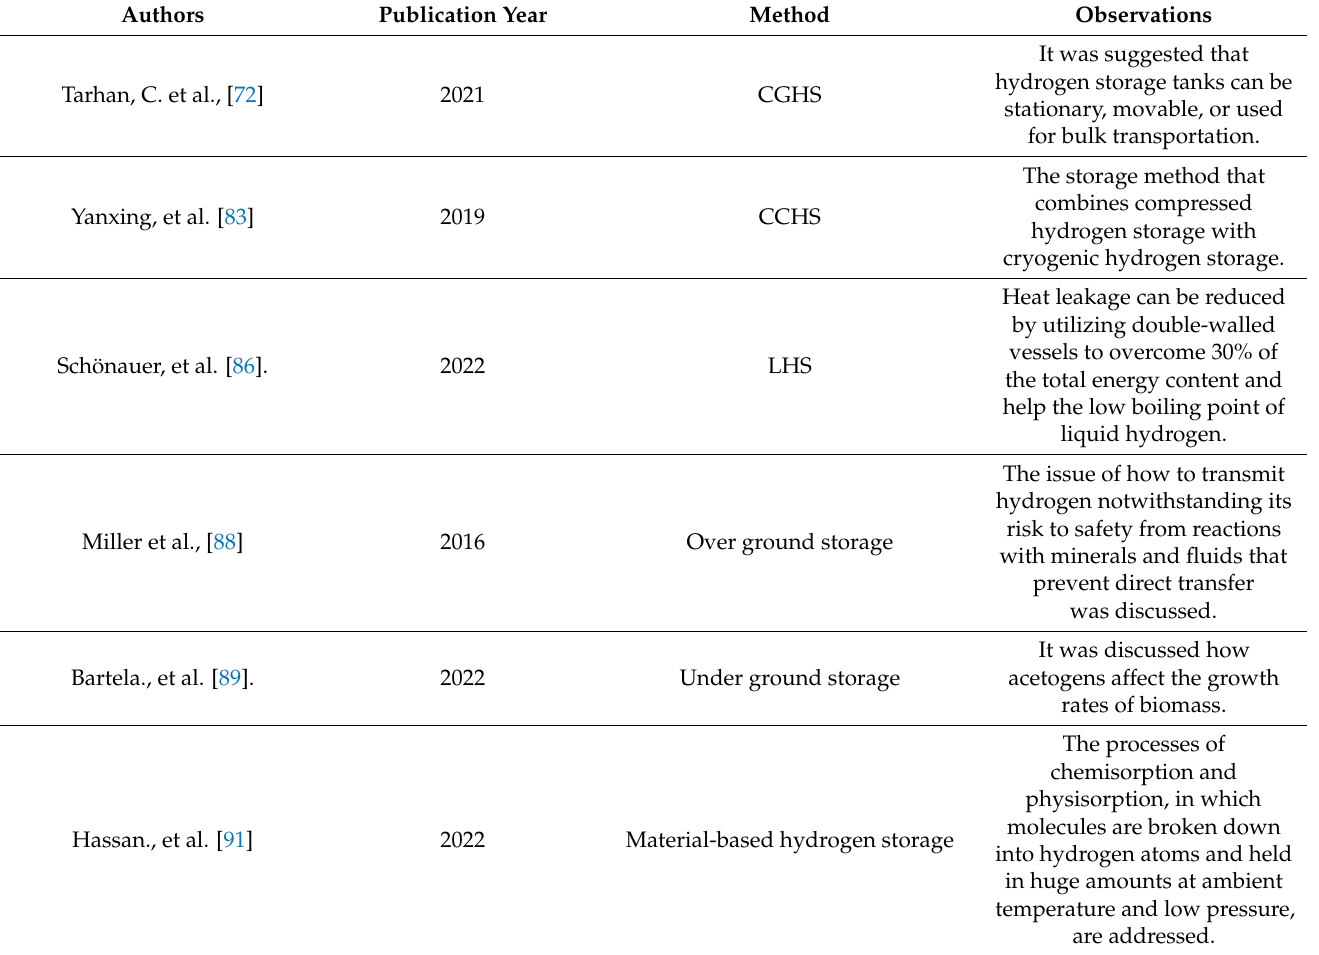
Table 2. Comparison of various hydrogen storage